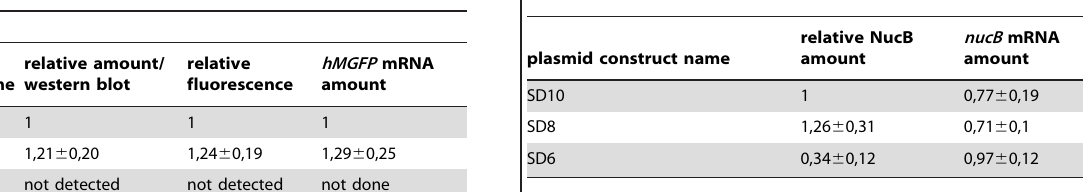
Table 5. Relative NucB protein level in P. bryantii TC1-1 cultures harboring pRH3 constructs containing start codon upstream sequences with SD sequences of different